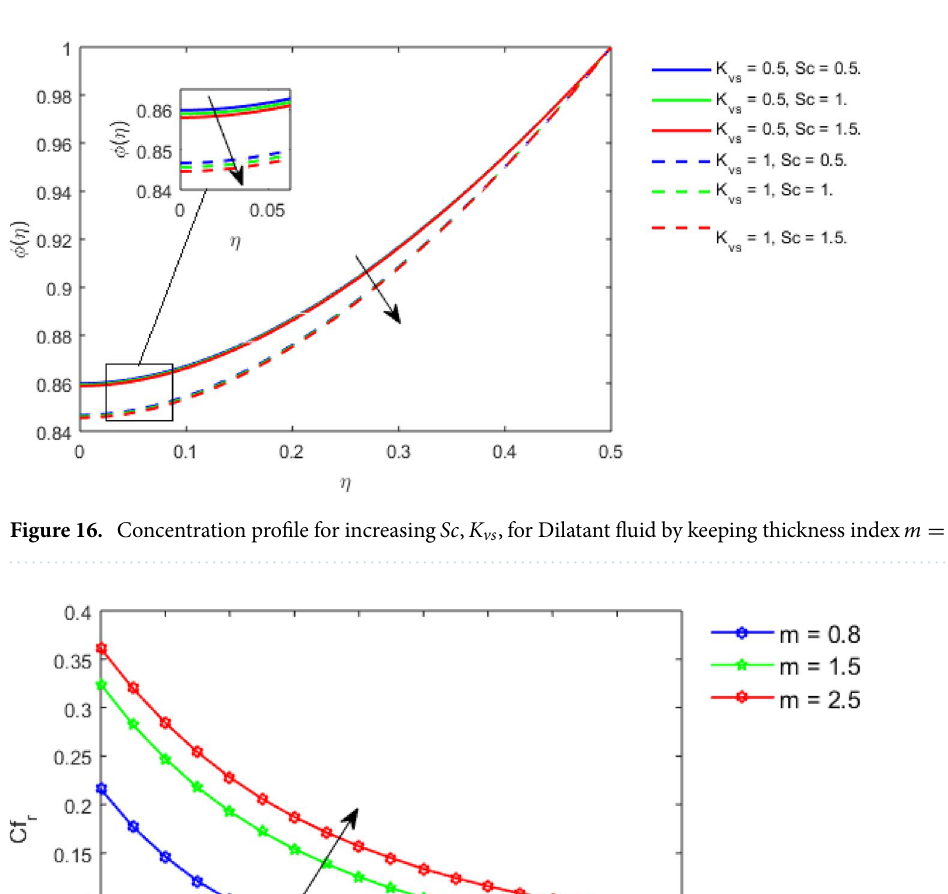
Figure 15. Thermal profile for increasing Nt , for Pseudoplastic fluid by keeping m = 0.8 .